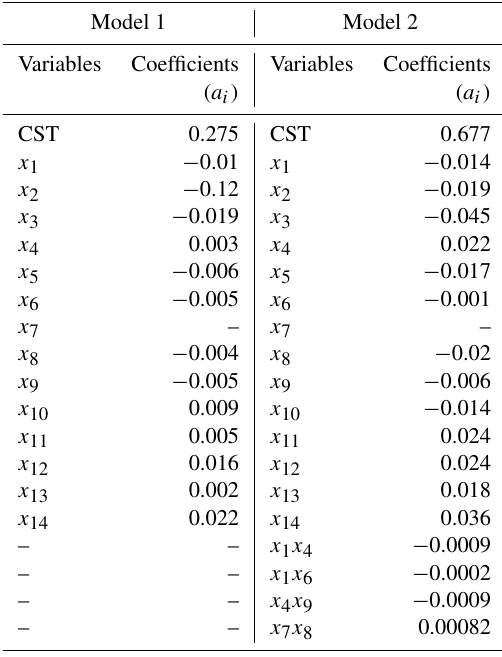
Table 3. The R 2 , R 2 and p values of the ANOVA test of two mul- adj tivariate regression models.